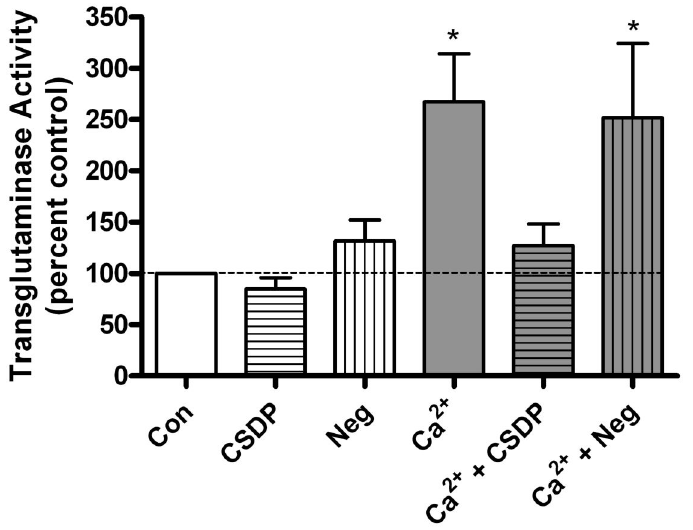
Figure 2. The caveolin-1 scaffolding domain peptide prevents the calcium-induced stimulation of transglutaminase activity. Keratinocytes were treated for 24 hours with SFKM containing vehicle (0.1% DMSO) or 3 µM caveolin-1 scaffolding domain peptide (CSDP) or the negative control (Neg) in medium containing 25 µM calcium (Con) or 125 µM calcium (Ca 2+ ), as indicated. Transglutaminase activity was then measured as described in Materials and Methods. Values are expressed as the percent control and represent the means ± SEM of 6 separate experiments performed in duplicate; *p<0.05 versus the control